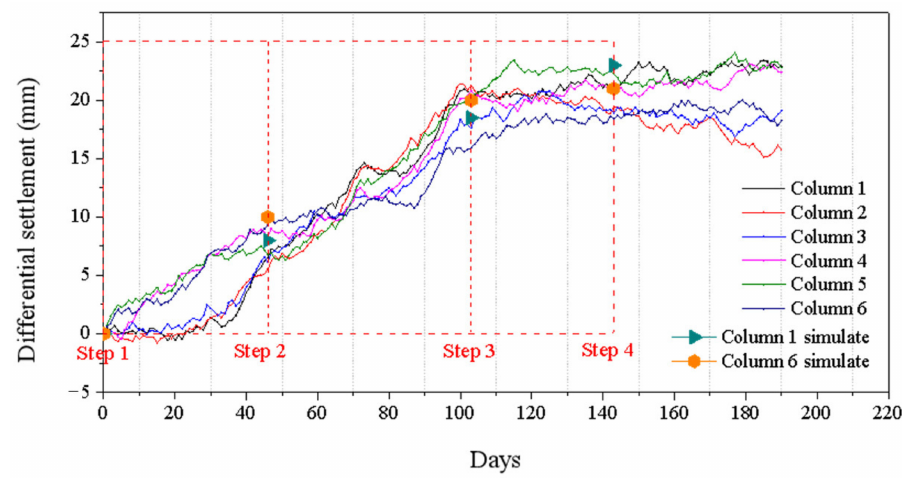
Figure 7. Differential settlement of the column during